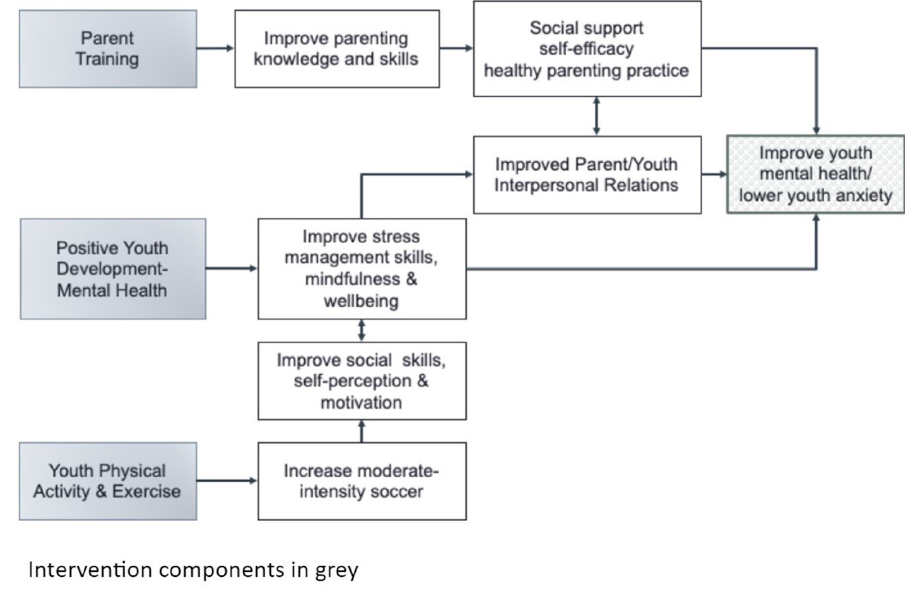
Figure 1. Conceptual